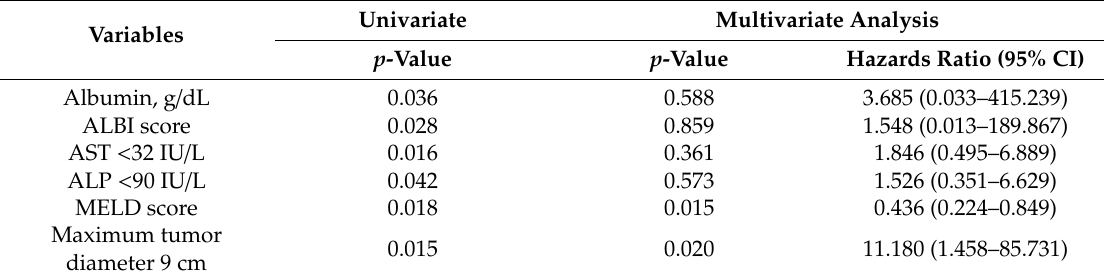
Table 3. Results of multivariate Cox regression analysis to identify predictors of complete